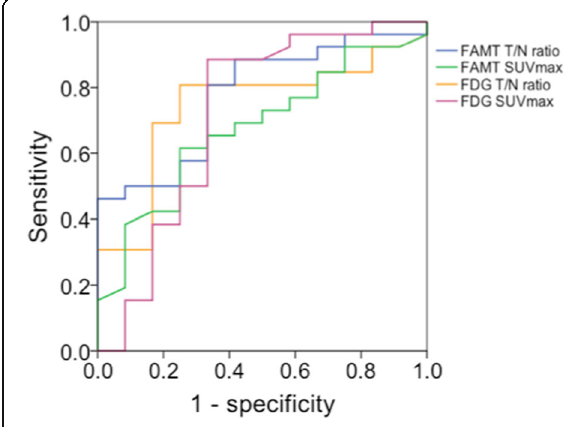
Fig. 2 ROC curve analysis of T/N ratio ( blue curve ) and SUV max ( green curve ) of 8 F-FAMT to differentiate between HGGs and LGGs. Area under the curve was 0.776 for T/N ratio ( p = 0.007, 95% CI 0.623 – 0.928, optimal cutoff 3.37) and 0.675 for SUV max ( p = 0.087, 95% CI 0.497 – 0.852, optimal cutoff 3.45). ROC curve analysis of T/N ratio ( orange curve ) and SUV max ( purple curve ) of 8 F-FDG to differentiate between HGGs and LGGs. Area under the curve was 0.742 for T/N ratio ( p = 0.018, 95% CI 0.575 – 0.909, optimal cutoff 0.92) and 0.716 for SUV max ( p = 0.034, 95% CI 0.510 – 0.923, optimal cutoff